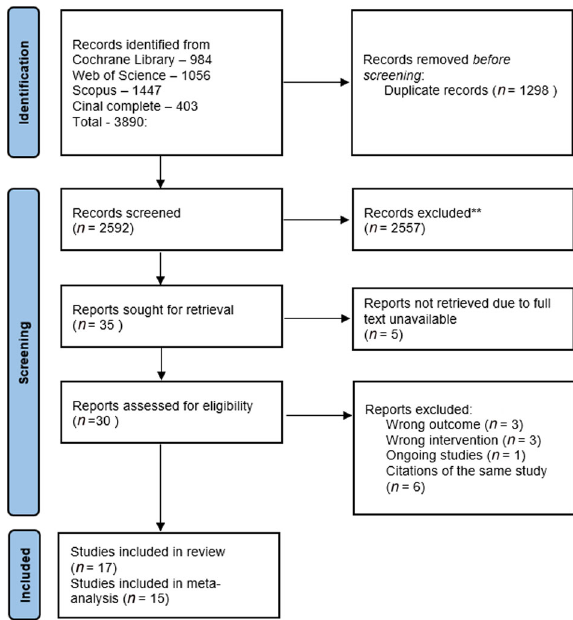
Fig. 1 PRISMA Flowchart for Study selection.